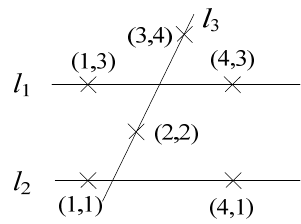
Figure 3. Example of lines with intersections.